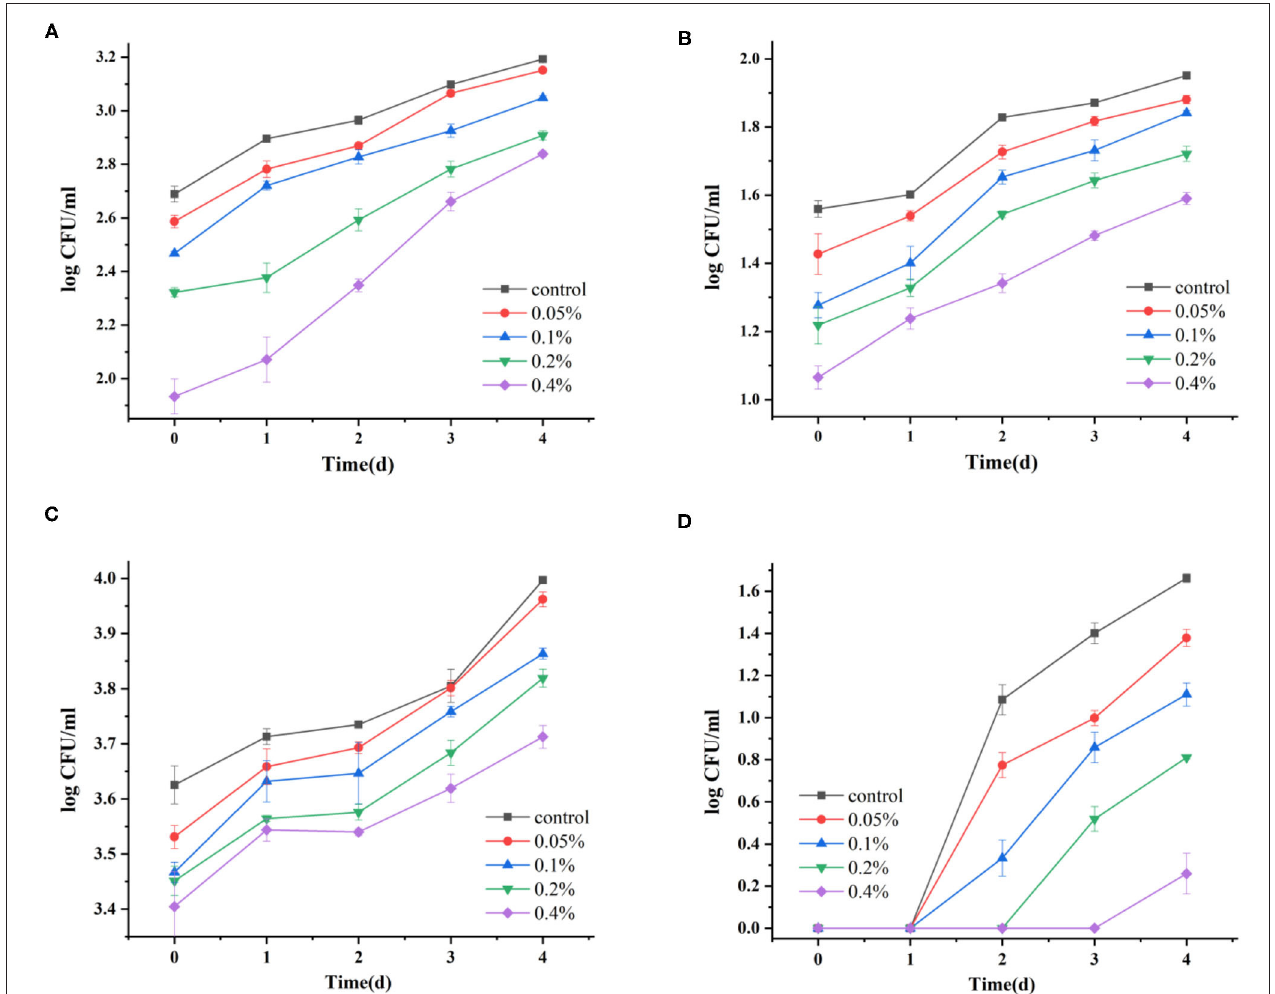
FIGURE 3 | The change of the total bacteria count, molds, and yeasts in pineapple juice. (A) The change of the total bacteria count by essential oil emulsion. (C) The change of molds and yeasts by essential oil emulsion. (B) The change of the total bacteria counts by essential oil emulsion and heat treatment. (D) The change of molds and yeasts by essential oil emulsion and heat treatment. (A,C) stored at 4 ◦ C. (B,D) stored at 25 ◦